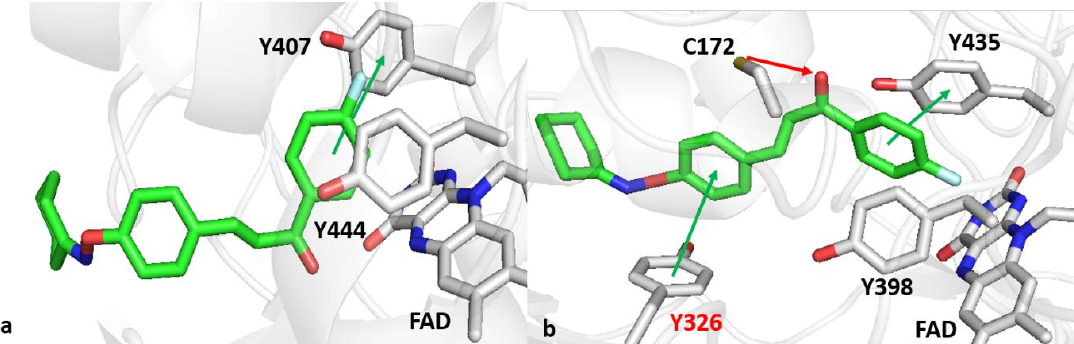
Figure 6. Top scored poses of COE-6 in the binding sites of MAO-A ( a ) and MAO-B ( b ). Proteins and